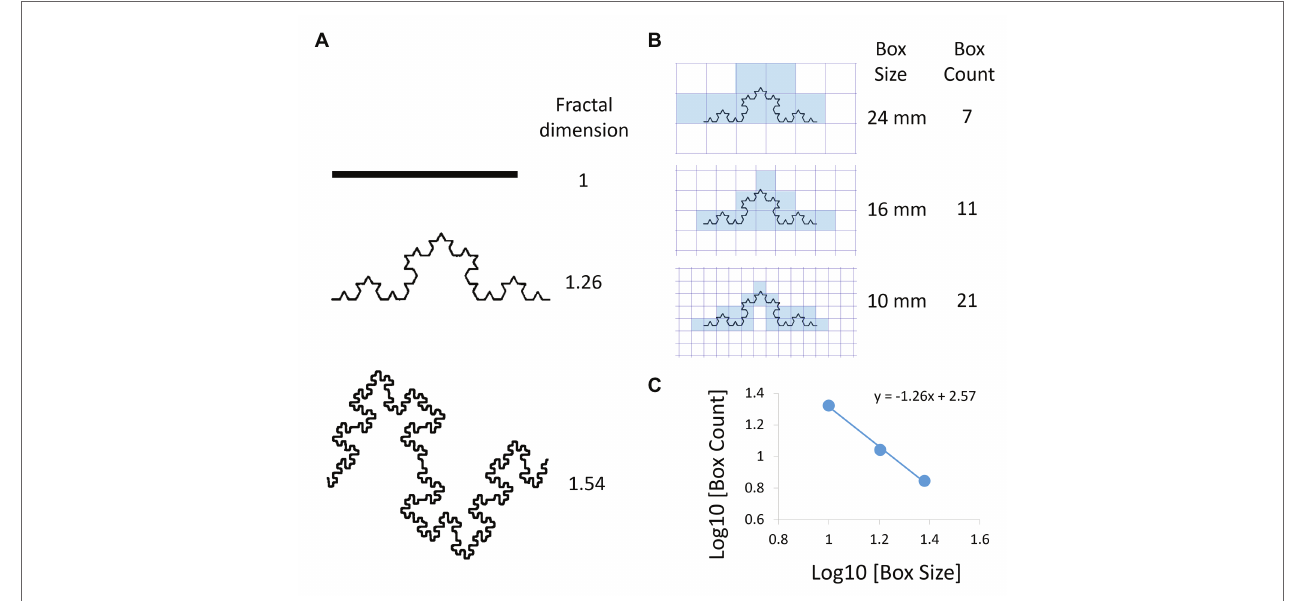
FIGURE 1 | Examples of fractal objects and the box-counting method to determine their fractal dimension (FD). (A) Comparisons of FDs between three objects. (B) Box-counting method to calculate FD. A box grid at a given size scale x is superimposed on the object. The number of boxes that include a part of the object N(x) is counted. The analysis is repeated for different values of x . (C) x and N(x) are plotted on a double logarithmic scale and the FD is calculated as the negative slope of the regression line (FD = 1.26 in this